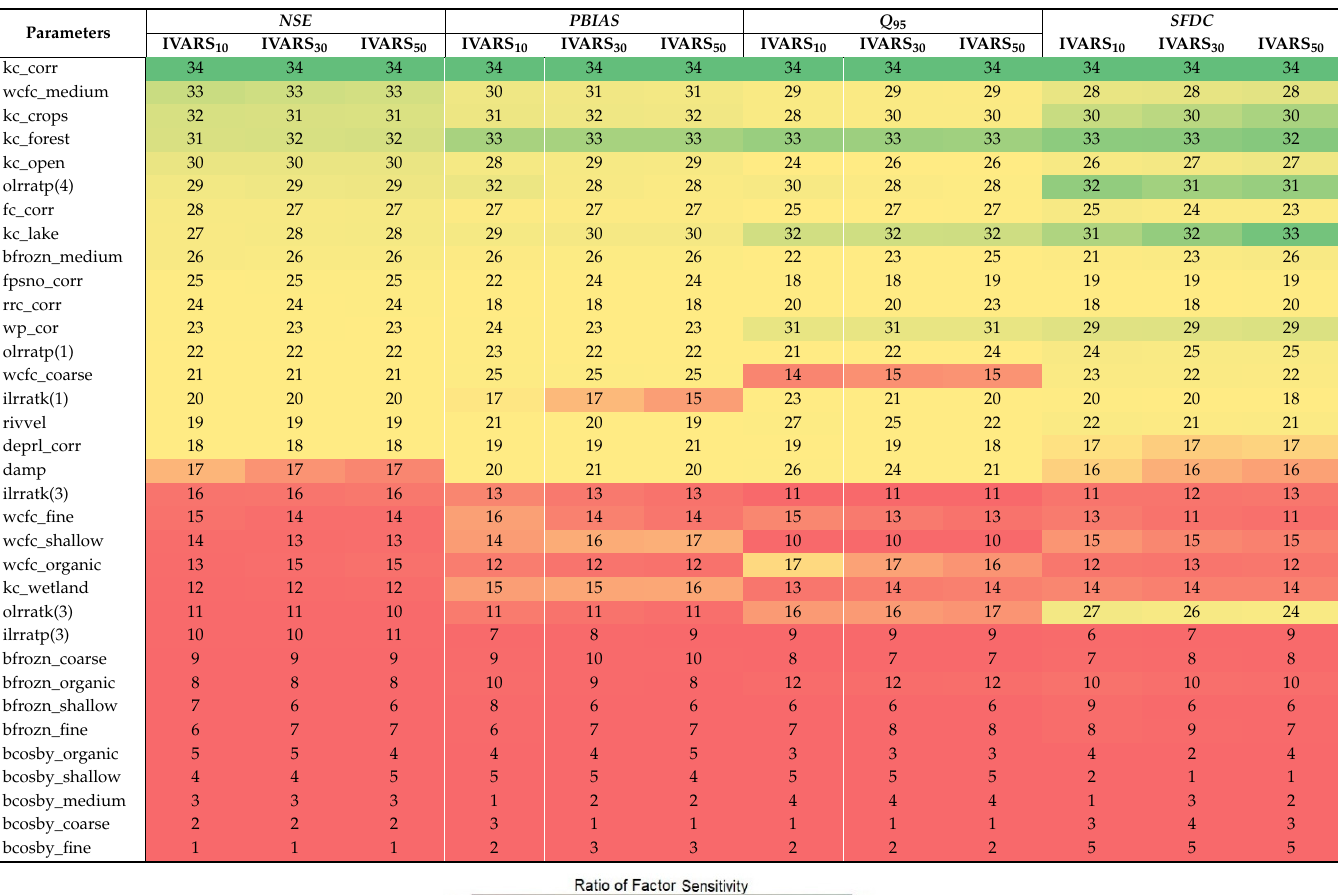
Table 3. Ranking of HYPE model parameters based on ratio of factor sensitivity from most influential (green) to least influential (red) IVARS 10 , IVARS 30 and IVARS 50 for di ff erent evaluation metrics determined using a long-term sensitivity analysis (SA).